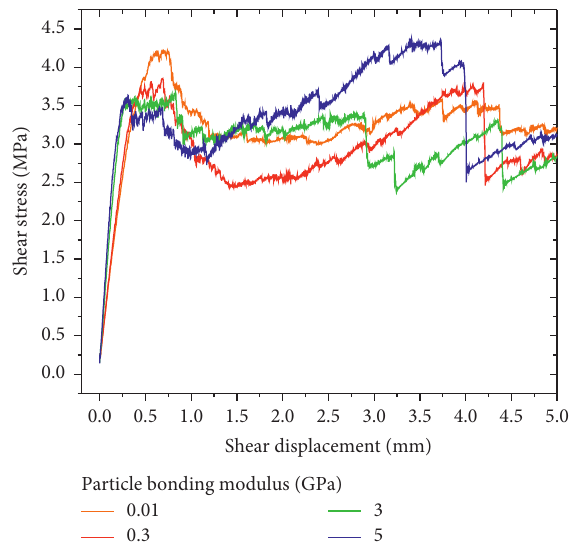
Figure 6: Shear stress deformation curves of bolted joints with different parallel bonding modulus.